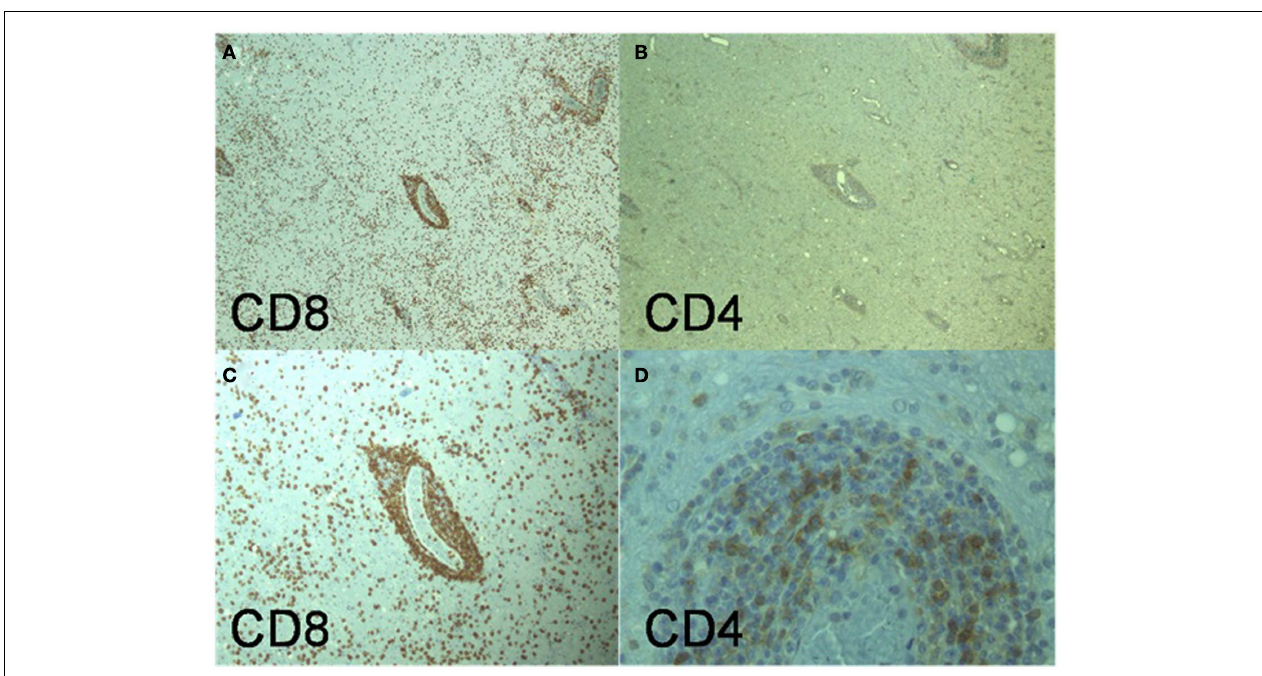
FIGURE 5 | (A,C) (Low and medium power magnification) Primarily CD8 positiveT-lymphocytes in the perivascular inflammatory infiltrates and prominent lymphocytic infiltrates in the parenchyma. (B,D) (Low and high power). Some CD4 positiveT-lymphocytes in the perivascular areas but very few in brain parenchyma infiltrates.